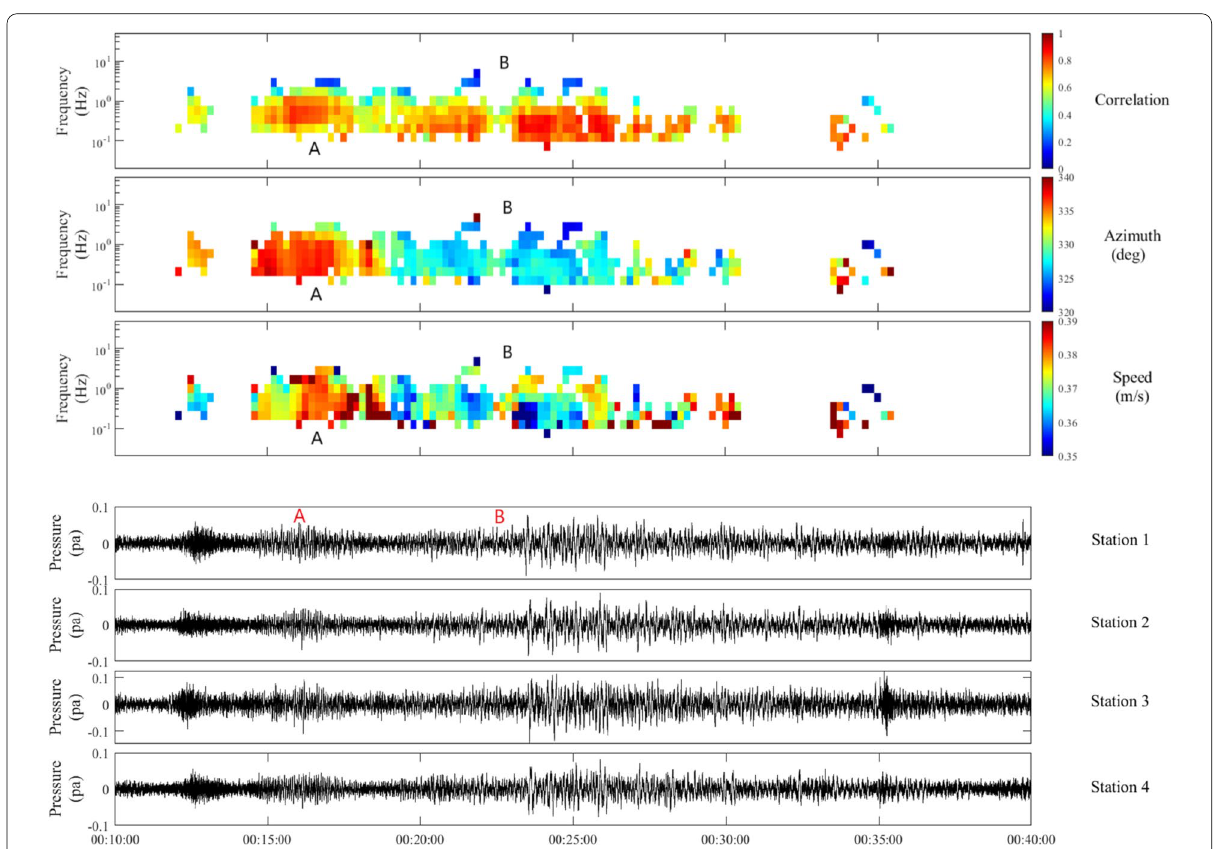
Fig. 2 PMCC results for the data from the infrasound station in Yunnan Province, China. According to the corresponding relationship between the PMCC family and the amplitude of the signal, the received signal can be divided into arrivals A and B, which are marked above. The azimuths and elevation angles (apparent velocity) of arrivals A and B are significantly different. The main frequency band of arrival B is lower than that of arrival A according to the correlation